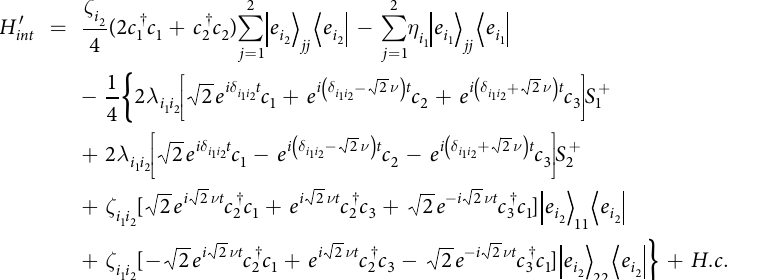
Figure 11. The fidelity of the iSWAP gate vias g and evolution time using master equation. ∆ = g 9 δ ∆ = + g 9 , ν = 4 g , κ = γ = β = 0.002g. Ω = g 2 . ( a ) The diamonds refer to ≈ . g 5 275 , the squares and the 2 circle refer, respectively, to a variation of − 0.025 and + 0.025 of g . ( b ) The diamonds refer to ≈ . g 18 4 , the squares and the circle refer, respectively, to a variation of − 0.05 and + 0.05 of g